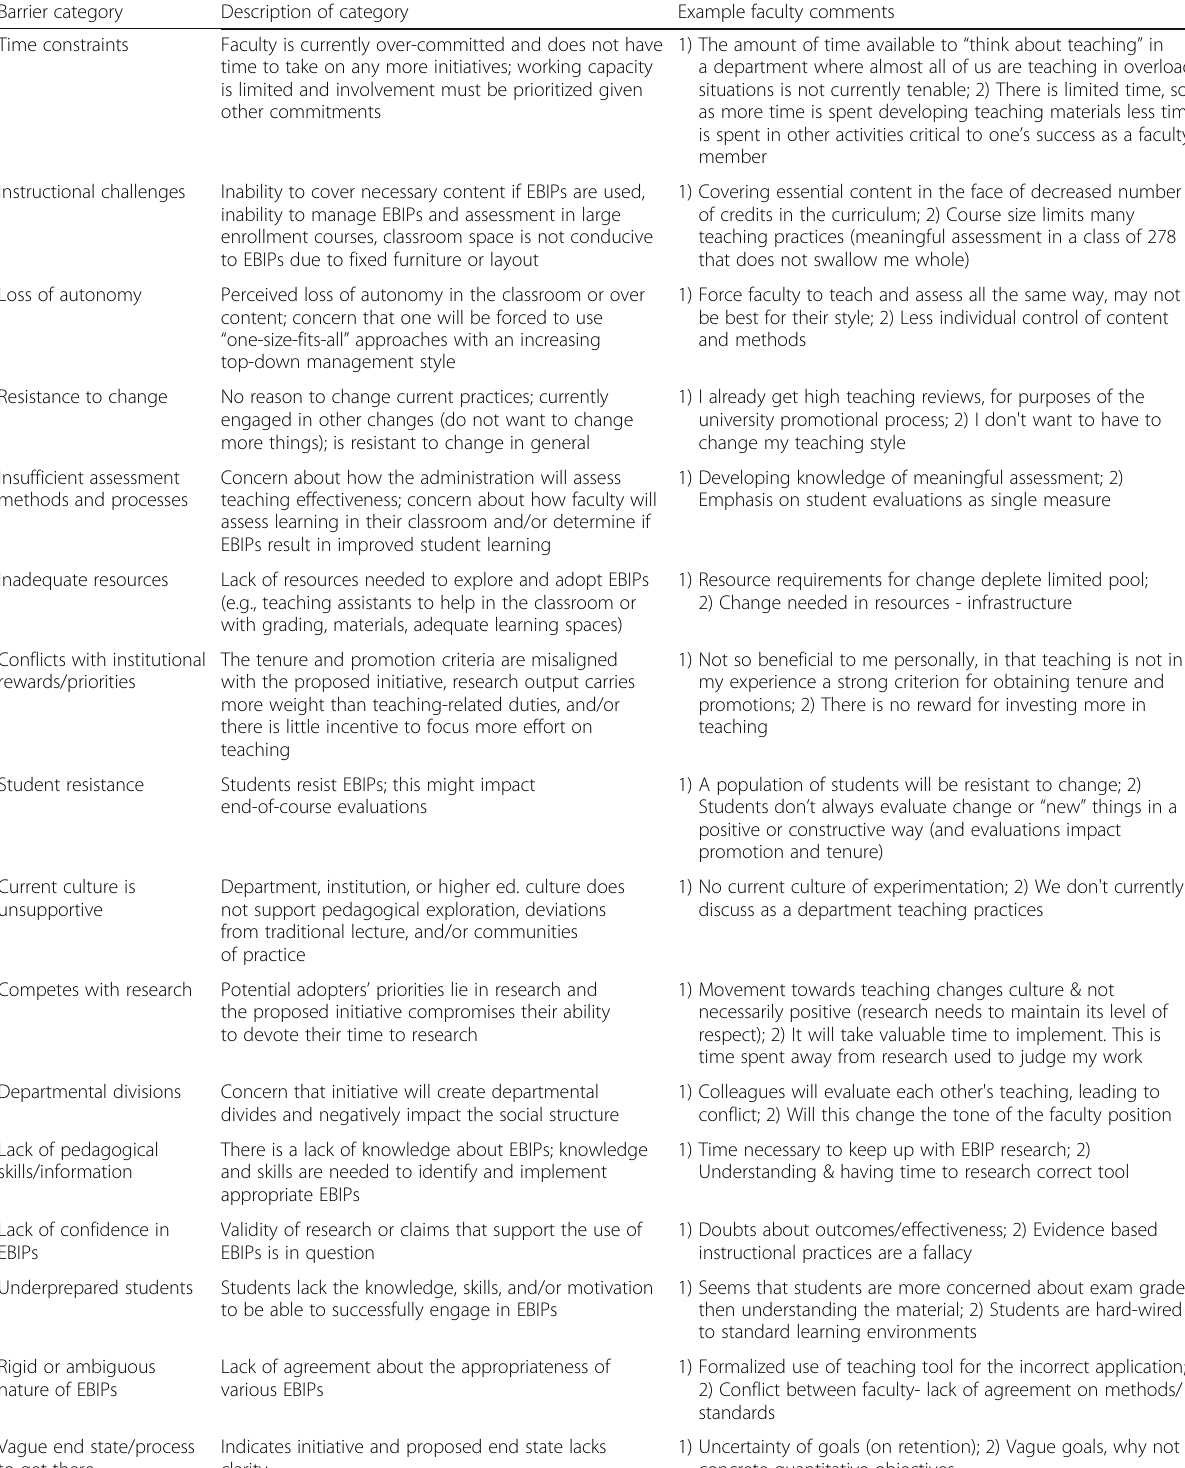
Table 2 Categories of faculty-identified barriers for STEM education